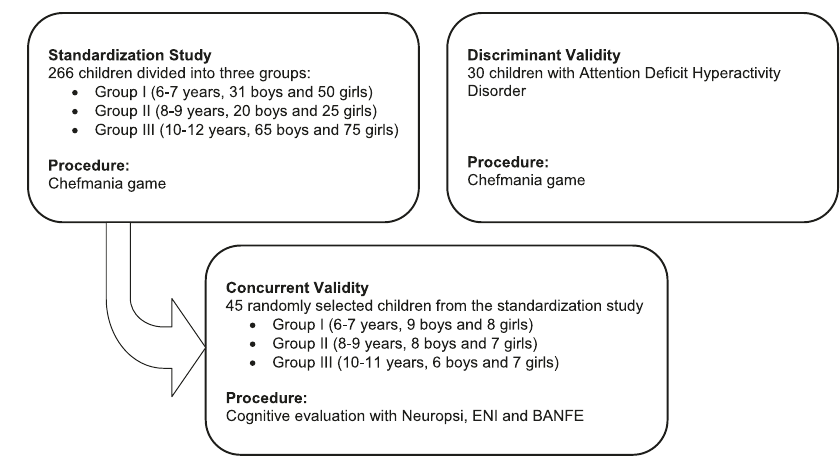
Fig. 2 Study design. Each panel shows the procedures and the number of participants in each stage of the